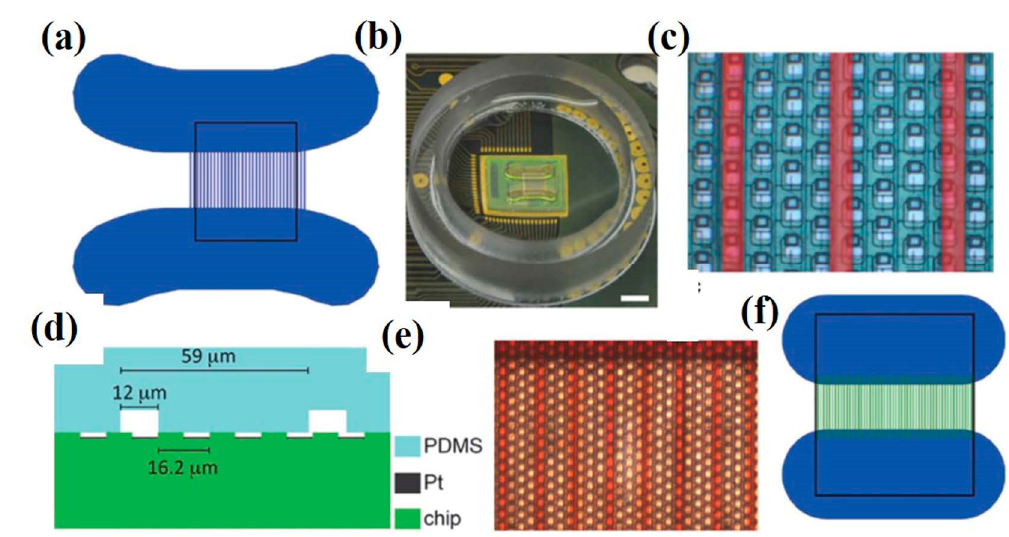
Figure 19. ( a ) The geometry of the microfluidic device on the microelectrode array. ( b ) Image of the packaged chip with the device on the top. ( c ) Magnified image of the electrodes and the channels; channels are highlighted with red, and the scale bar is 10 μ m. ( d ) Cross-section of chip depicted with dimensions. ( e ) The images of the channels are highlighted in red; the scale bar is 20 μ m. ( f ) The device with a small chamber and channels with an array marked inside the black box. Reprinted with permission from [193].